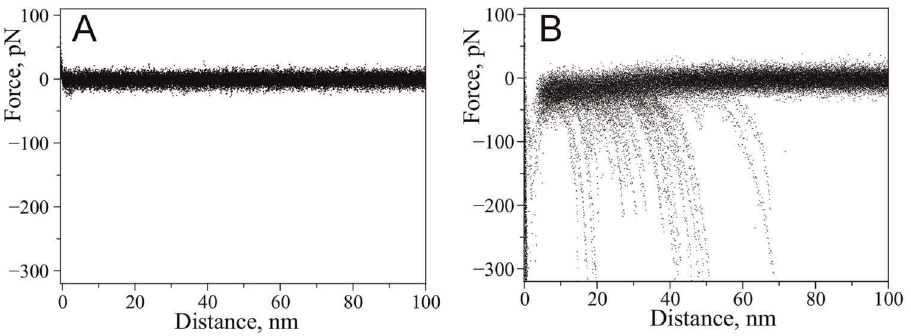
Figure 3. Effect of spermidine on the appearance of force-distance curves with A30P alpha-synuclein. Superposition of representative force-distance curves measured upon probing of interactions between A30P alpha-synuclein molecules: A) in the absence of spermidine (40 curves), B) with addition of 5 mM spermidine (58 curves).